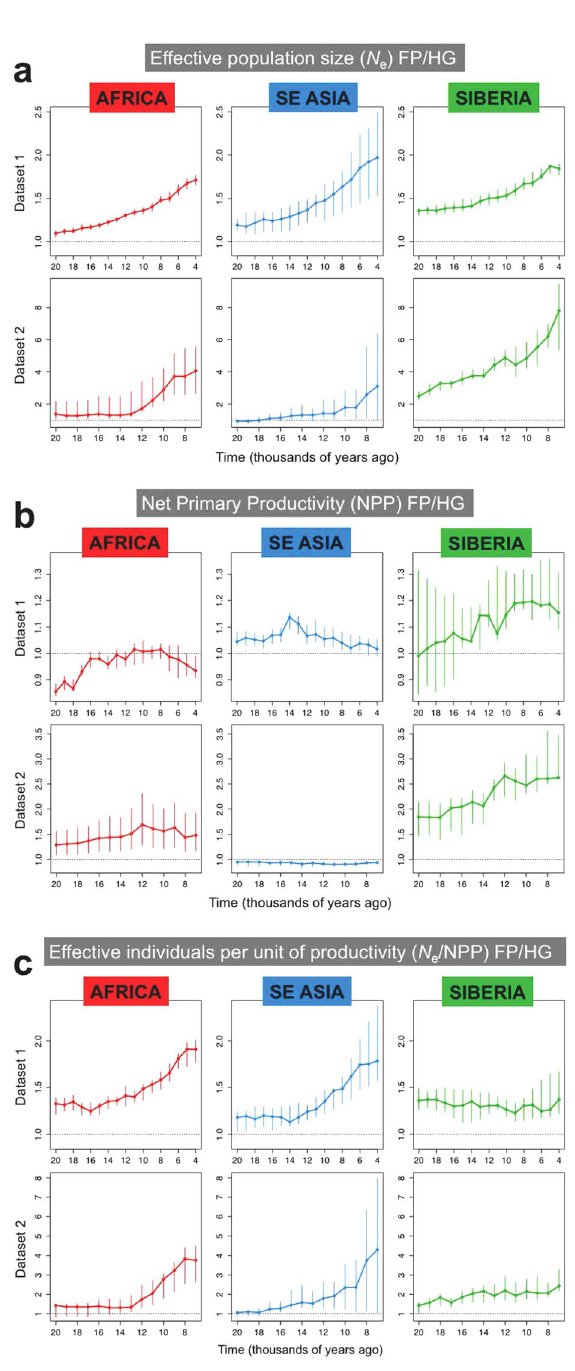
Figure 2. Median of the ratio of food producers over hunter-gatherers for N e ( a ), NPP ( b ) and N e /NPP ( c ) in the three regions considered: sub-Saharan Africa, south-eastern Asia and Oceania, and Siberia. The plots show the temporal range between 4,000 and 20,000 years ago for dataset 1 and between 7,000 and 20,000 years ago for dataset 2. The error bars represent the 95% distribution of the jackknife leave-one-out